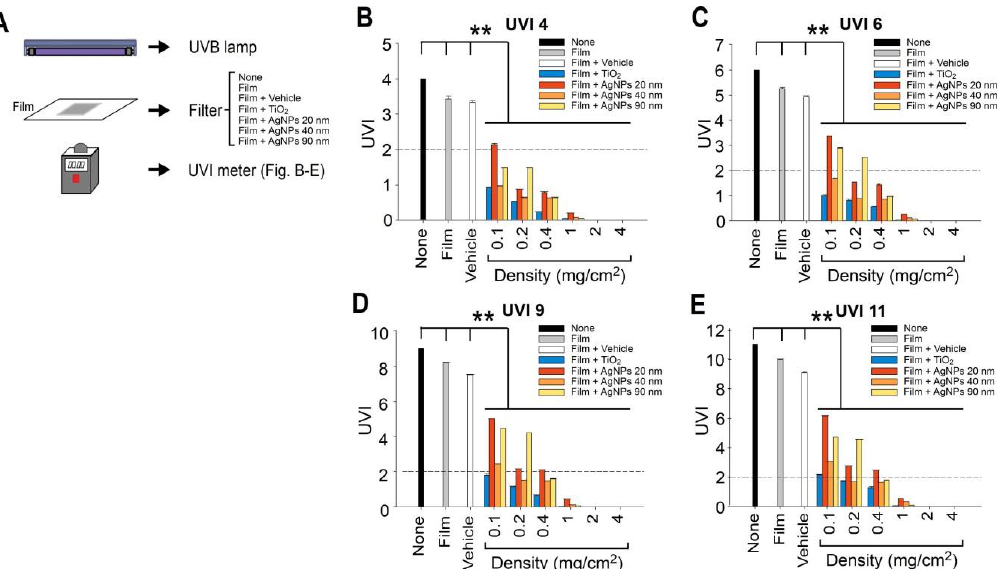
Figure 1. UVB attenuation by TiO 2 NP- and AgNP-coated plastic films. Experiment setting ( A ). Detected UVB levels of the NP-coated films at various NP densities. UVB at UVIs of 4 (100 M W /m 2 UVEry) ( B ), 6 (150 M W /m 2 UVEry) ( C ), 9 (225 M W /m 2 UVEry) ( D ), and 11 (275 M W /m 2 UVEry) ( E ). The dashed line indicates a UVI of 2 (50 M W /m 2 UVEry). UVB UVI below this level is considered safe (B–E). n = 3, ** p < 0.001. UVB, ultraviolet B; UVI, ultraviolet index; AgNP, silver nanoparticle; TiO 2 , titanium dioxide. Data are represented as mean ± standard